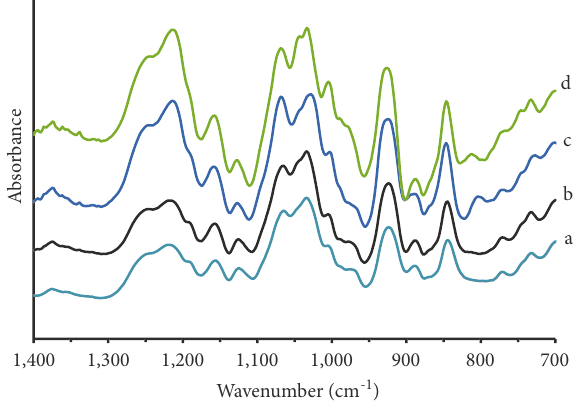
Figure 3: Infrared spectra of carrageenan extracted from H. bryoides at 4% NaOH, 2h, and 70 ∘ C condition (a) compared to kappa (b), iota (c), and kappa/lambda (d) commercial carrageenans.